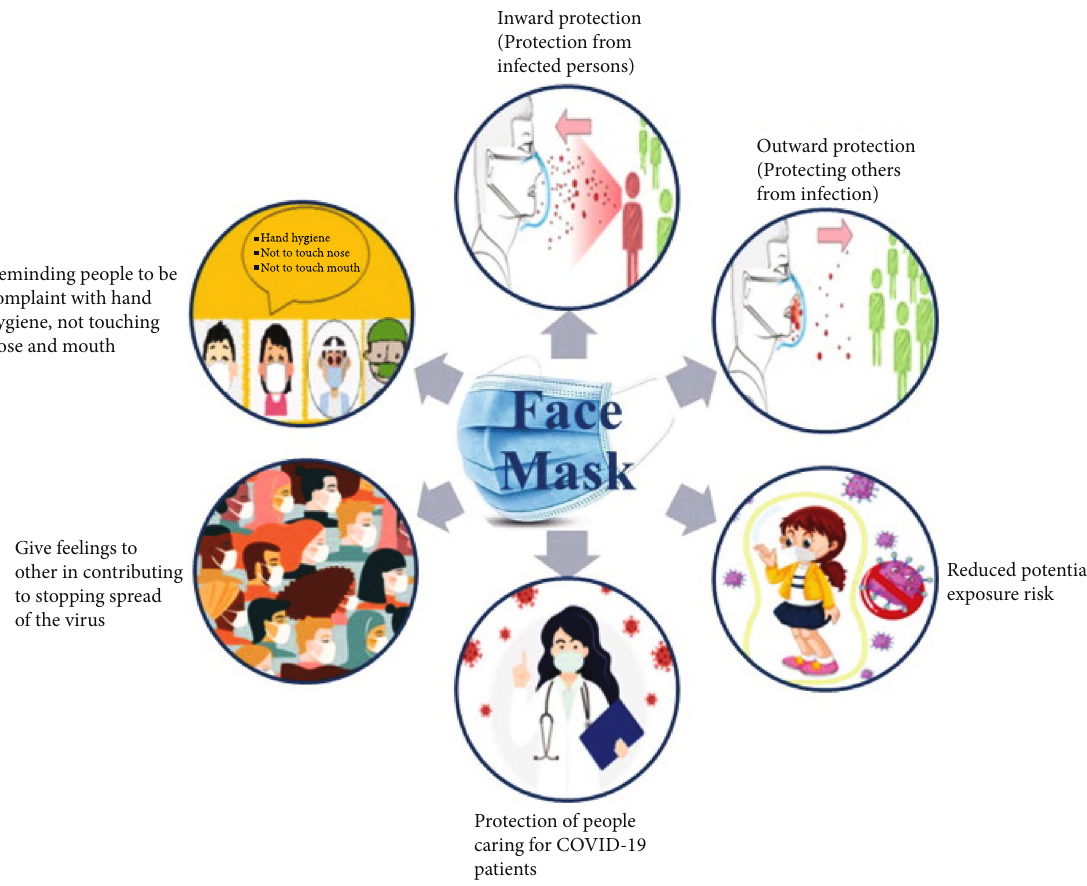
Figure 1: Protection o ff ered by face masks to healthcare and non-healthcare workers